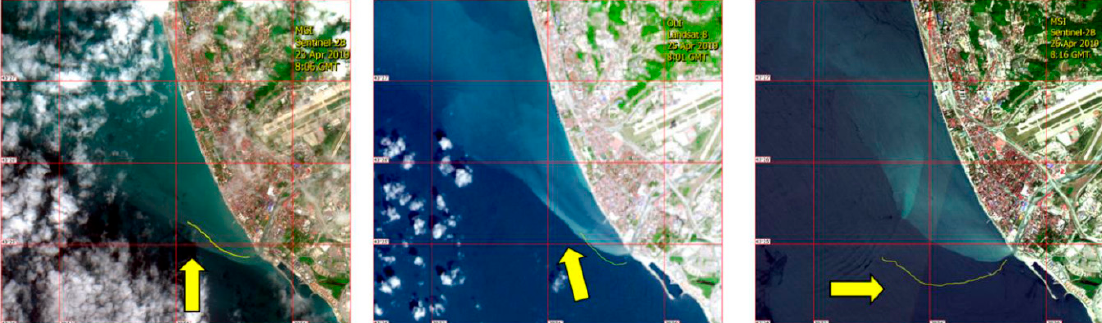
Figure 13. River plume boundary at the time of satellite overflight in the images of 23, 25 and 26 April 2019 (true color images (TCI)). In the images, yellow line is a GPS track along the boundary of the plume 3 h after the satellite overflight. Yellow arrow indicates prevailing wind direction.